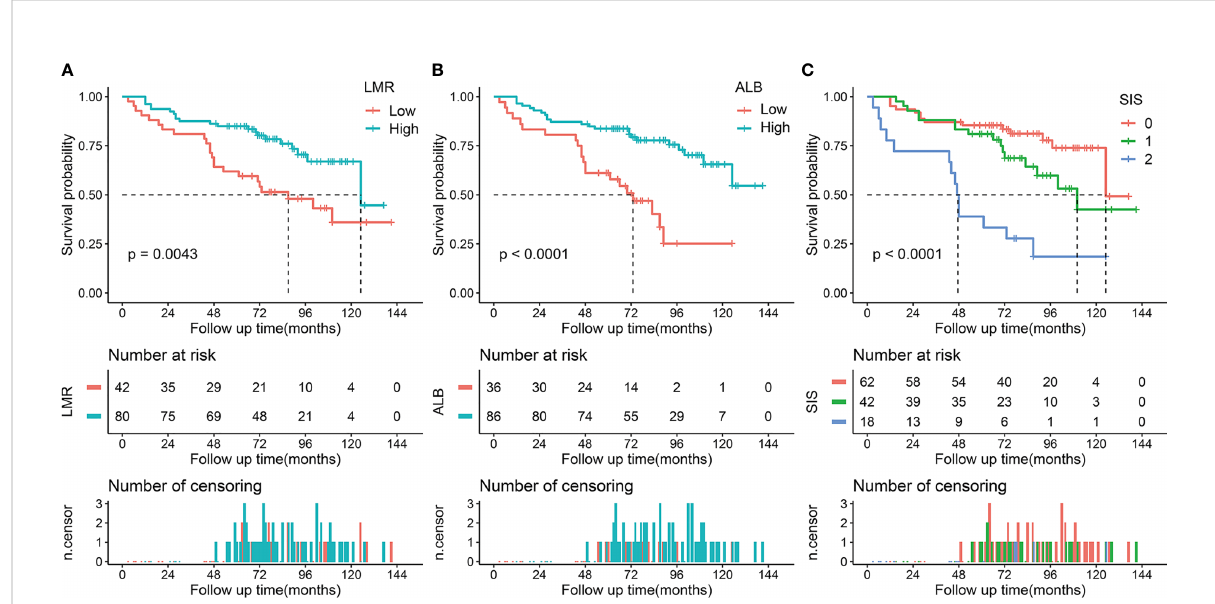
FIGURE 1 Kaplan-Meier survival analysis of LMR, ALB, and SIS in the training cohort. (A) Low LMR correlated with a poor OS. (B) Low ALB correlated with an adverse OS. (C) High SIS was associated with a poor OS. LMR, lymphocyte to monocyte ratio; ALB, albumin; SIS, systemic in fl ammation score; OS, overall